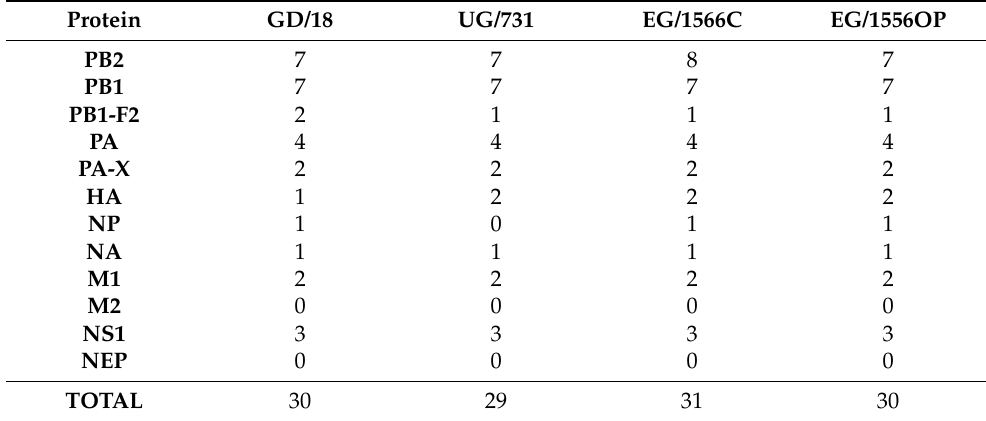
Table 1. Number of amino acid markers of mammalian adaptation, pathogenicity, and antiviral resistance identified in each protein of H6N2